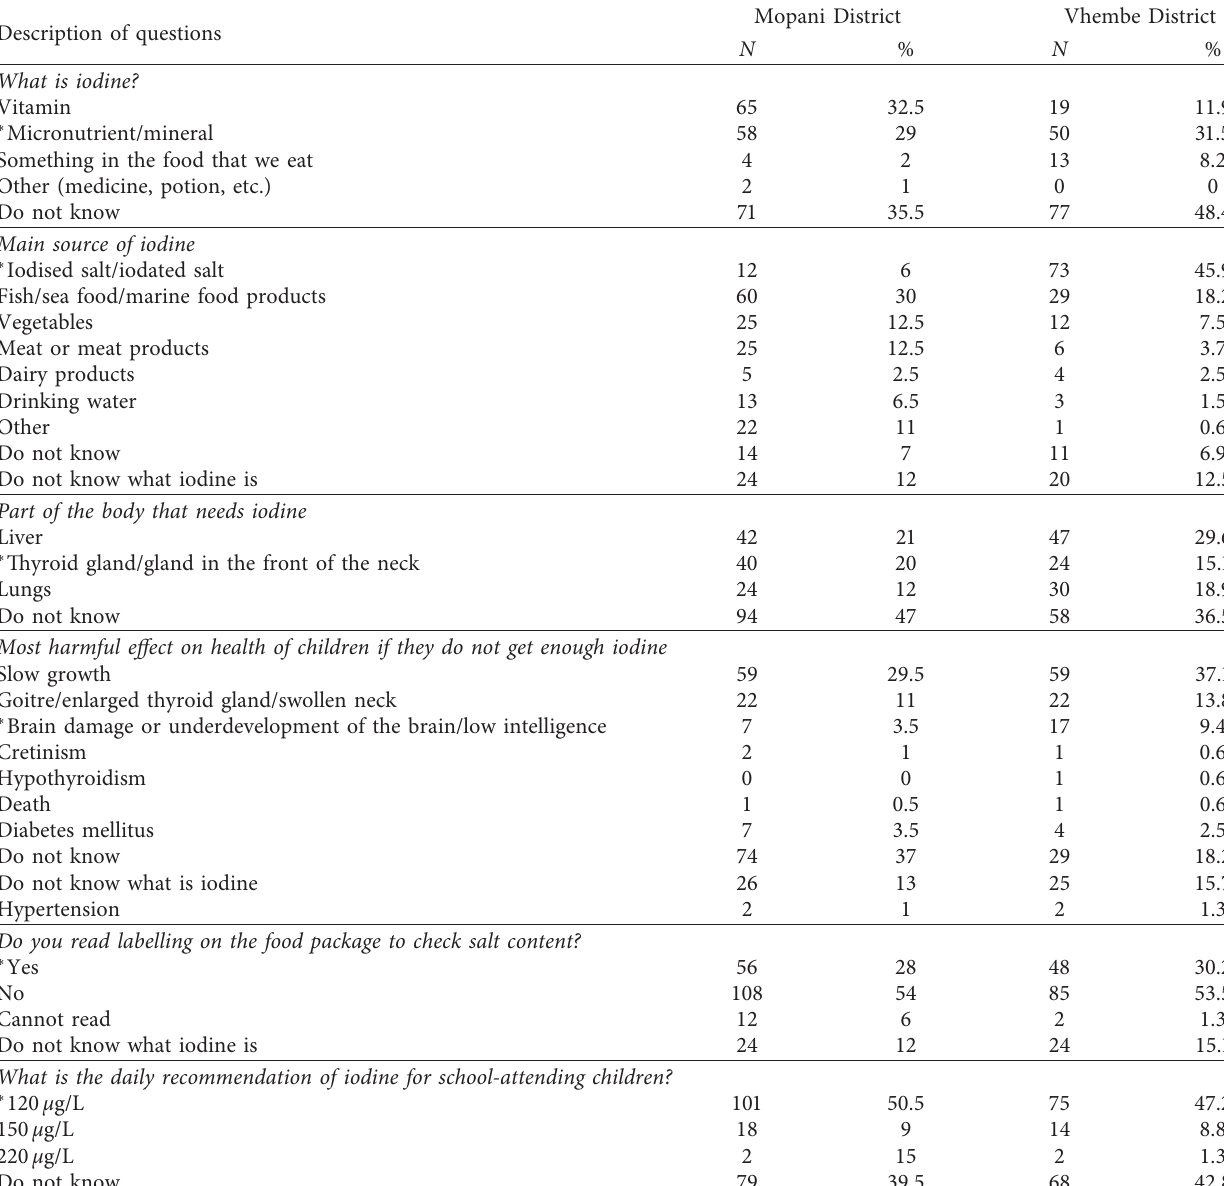
Table 5: Iodine nutrition knowledge